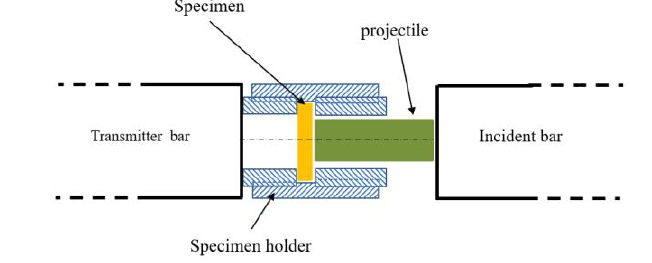
Figure 1. Schematic of the dynamic shear punch assembly coupled to SHPB experimental system